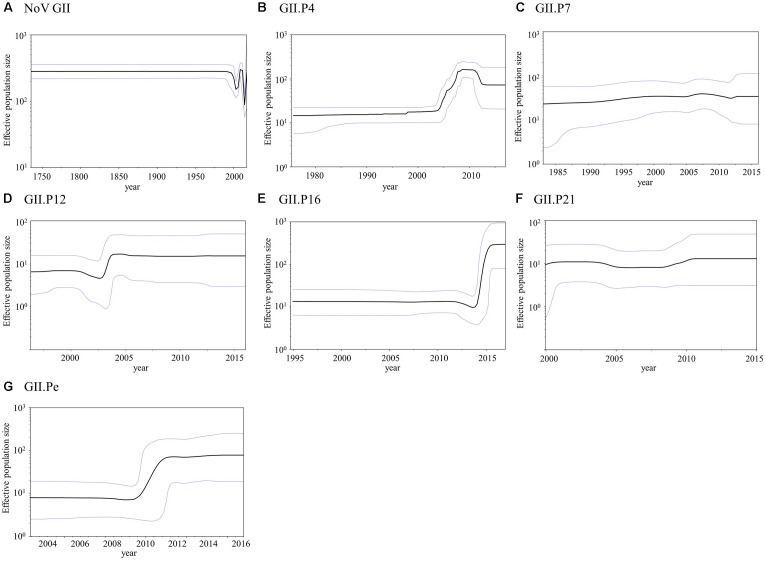
Bayesian skyline plot for the norovirus GII strains. Plots for norovirus GII (A), GII.P4 (B), GII.P7 (C), GII.P12 (D), GII.P16 (E), GII.P21 (F), and GII.Pe (G) are shown. The y-axis represents the effective population size on a logarithmic scale, and the x-axis denotes the time in years. The solid black line indicates the mean posterior value, and the blue lines indicate intervals with 95% HPD.